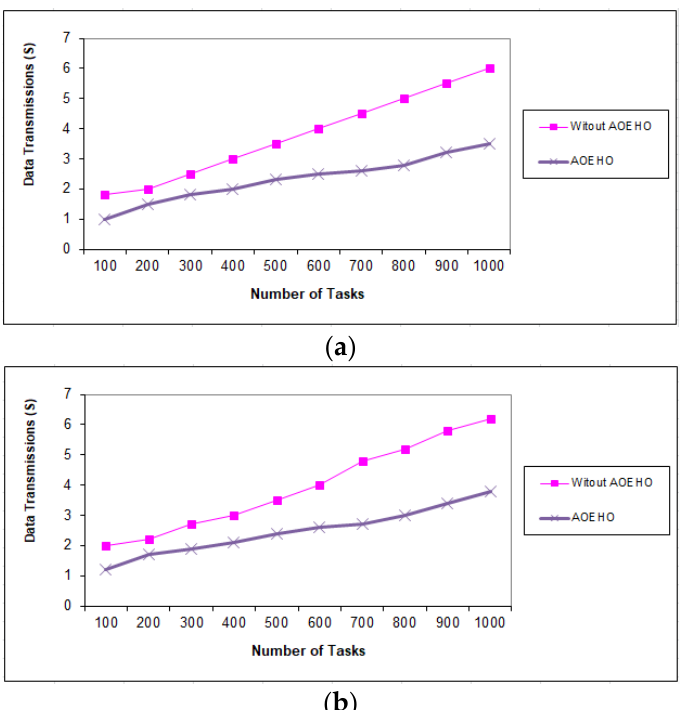
Figure 11. Data transmission between tasks = 1000 tasks. ( a ) Size of data replication = 64 MB. ( b ) Size of data replication = 320 MB.